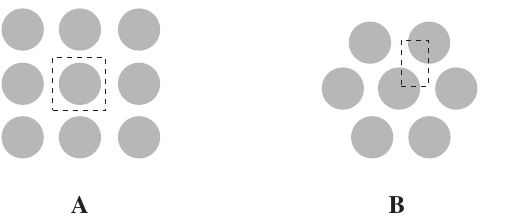
Figure 2 Cross-section of idealized unidirectional fibre arrays: (A) quadratic and (B) hexagonal.